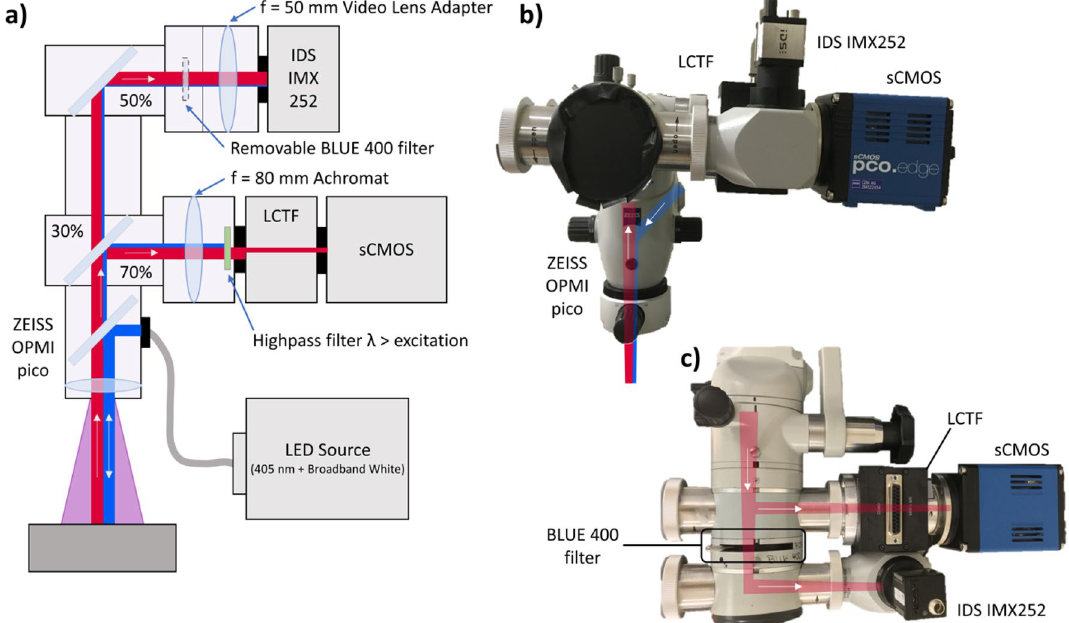
Figure 2. ( a ) Schematic illustration, ( b ) front view, ( c ) top view of the hyperspectral system used for ex vivo fluorescence imaging. Excitation light at 405 nm and broadband white light were delivered by an LED source (blue, bold). The emitted light (red, bold) from the sample was detected using the sCMOS camera after passing the LCTF, while the reflected light (blue, narrow) was filtered out by a highpass filter. An IDS color camera was additionally used to create a color image if desired with the BLUE 400